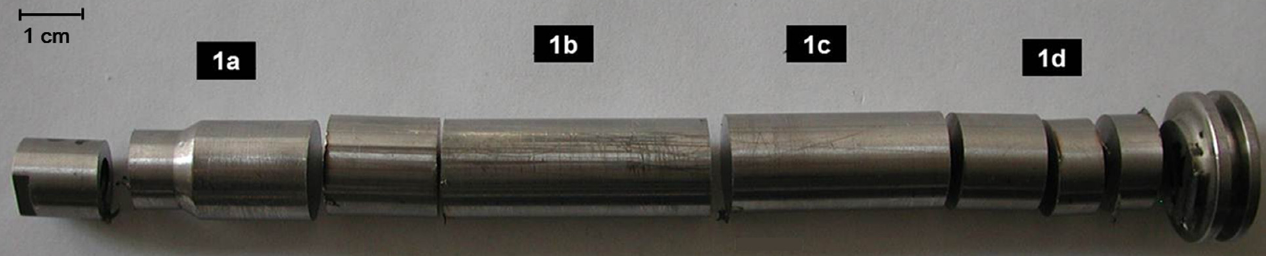
Figure 1: Sliding piston, sectioned in smaller samples for the failure